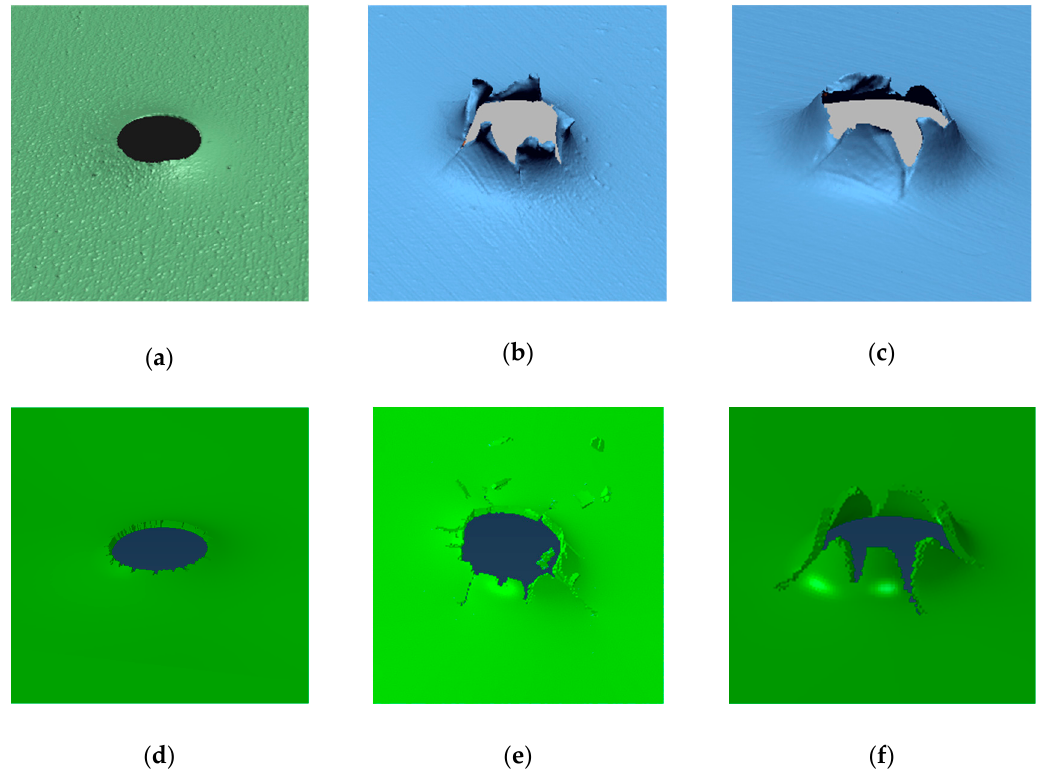
Figure 15. Failure experimental mode: ( a ) blunt, ( b ) conical and ( c ) hemispherical. Failure numerical mode: ( d ) blunt, ( e ) conical and ( f ) hemispherical.